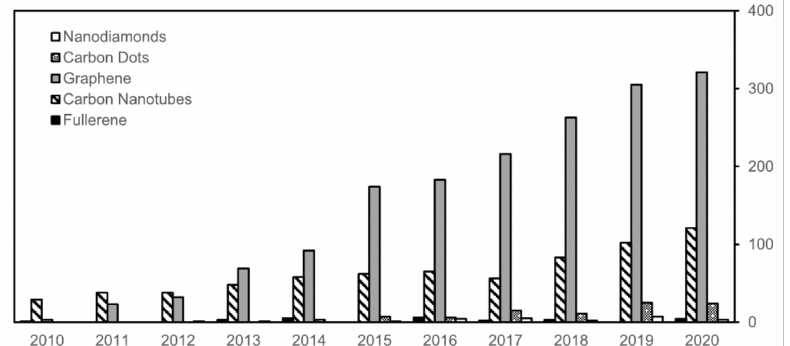
Figure 2. Results of a literature search (22 April 2021) on Scopus for documents over the last decade with the keywords “hydrogels” and one of the carbon nanomaterials as shown in the legend. The results pertaining nano-onions, nanohorns, or nanodiscs were <10 in total and are